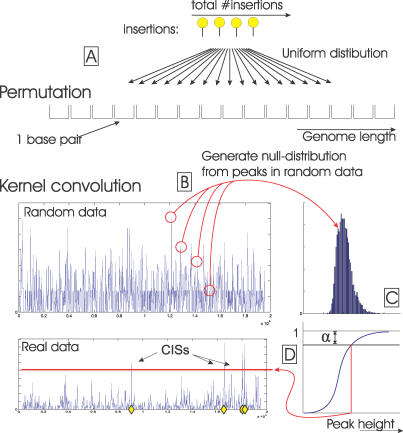
Schematic Depiction of the Significance Analysis of the Density Estimate of the Insertion Data(A) The position of the N insertions is permuted.(B) The convolution method is applied to the resulting permuted insertion profile. The heights of all peaks are recorded.(C) Step A and B are repeated. A distribution of the peaks in random data results.(D) The threshold is computed by determining the α-level in the empirical CDF of the null-distribution. This threshold is applied to the insertion estimate of the real insertion data, resulting in a series of significant peaks.